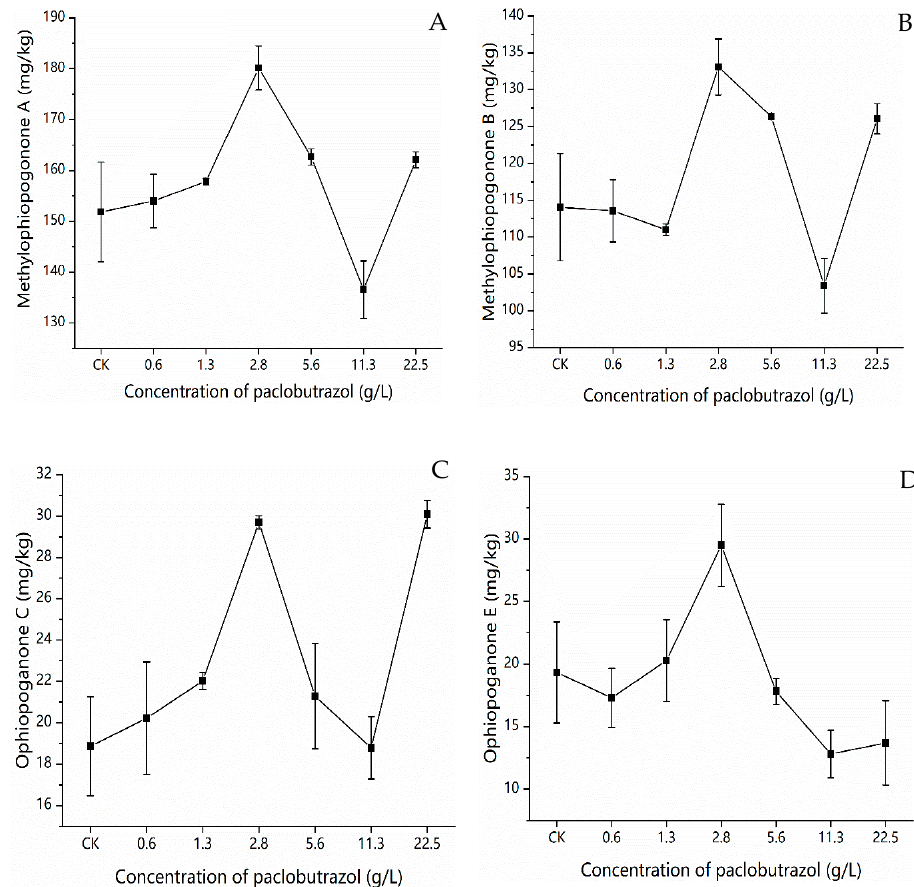
Figure 8. Effects of different concentrations of paclobutrazol on Methylophiopogonone A ( A ), Methylophiopogonone A ( B ), Ophiopoganone C ( C ) and Ophiopoganone E ( D ) content. Vertical bars represent standard errors.